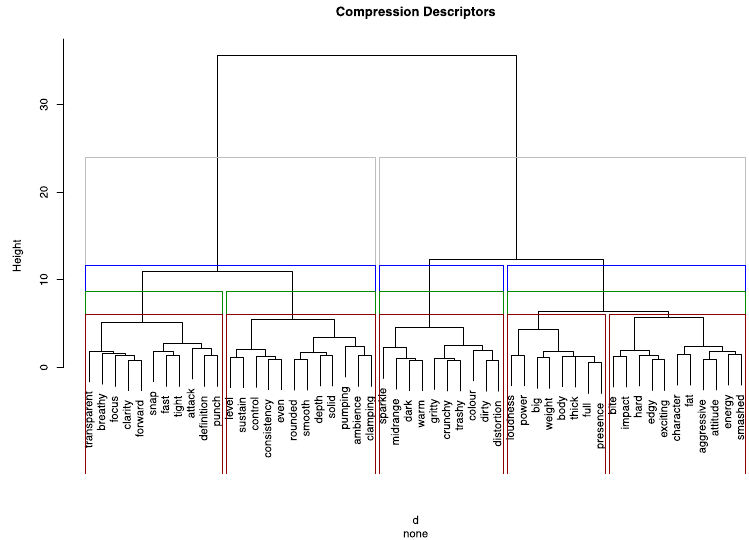
Figure 1. Results of clustering using the Ward method. The descriptors are split into five subsets (brown), four subsets (green), three subsets (blue) and two subsets (grey) .